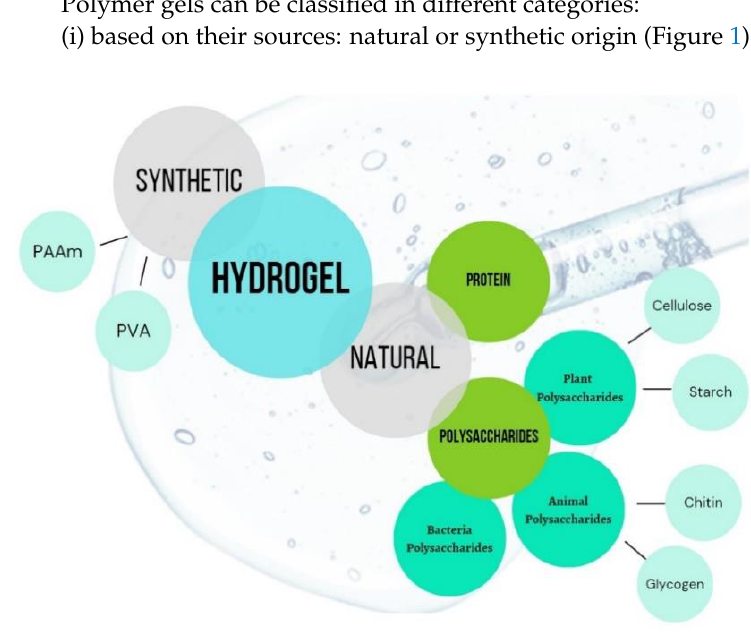
Figure 1. Type of materials used for synthesis of hydrogel based on their origin